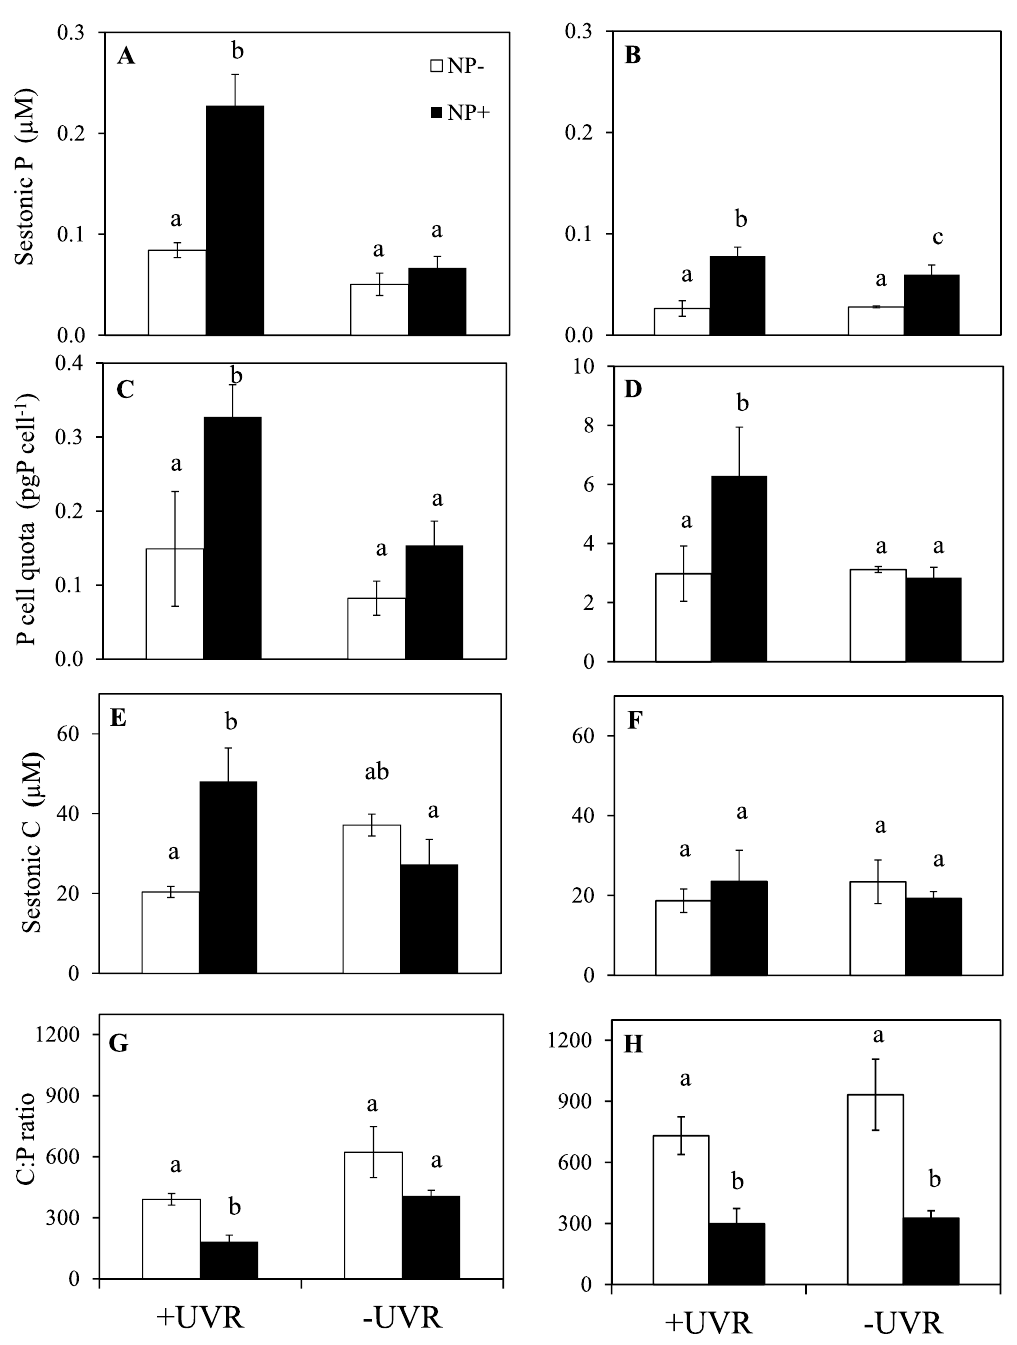
Figure 3. Elemental content of the sestonic fraction under the experimental conditions. Stoichiometric variables of sestonic fraction under radiation [full sunlight ( + UVR) and photosynthetically active radiation ( − UVR)] and nutrient treatments [nutrient-enriched (NP + ) and non-enriched (NP − )] in La Caldera and Los Cántaros lakes. Sestonic Phosphorous (P) ( A , B ); P cell quota ( C , D ); sestonic Carbon ( C ) ( E , F ); sestonic C:P ratio ( F , G ). Data are expressed as mean values ± SD (n = 3). Significant differences among treatments are denoted by different lower-case